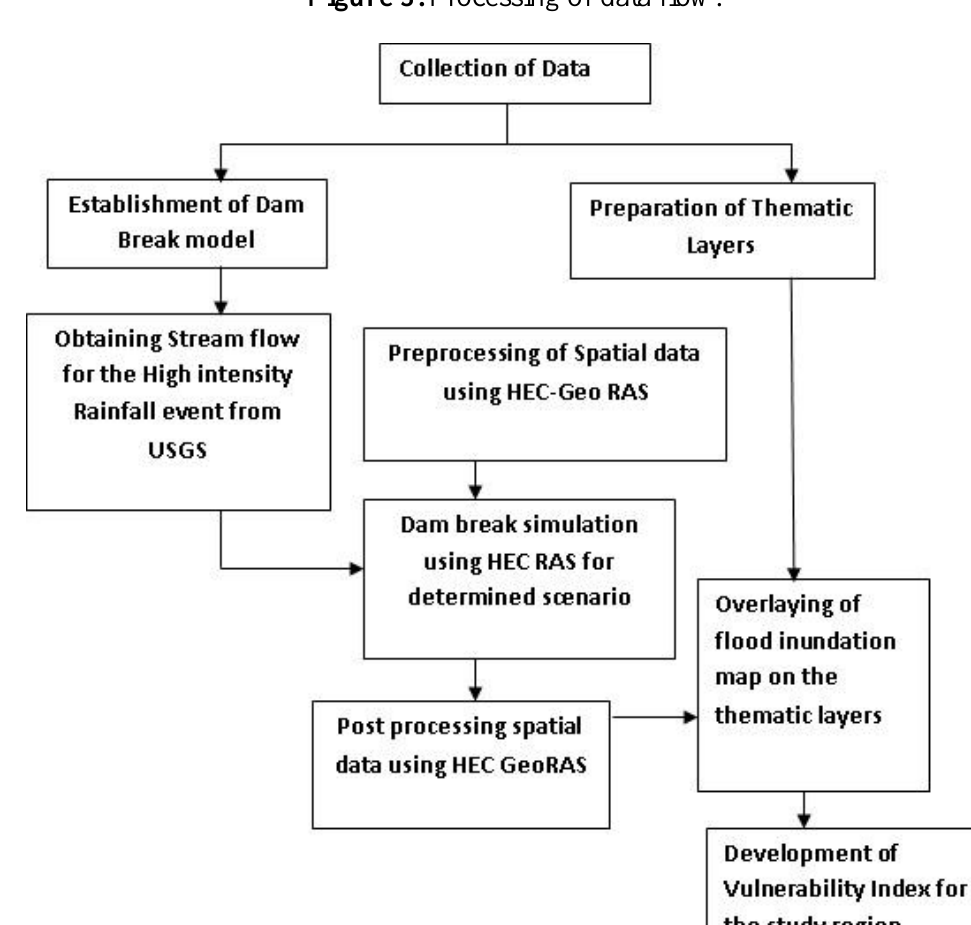
Figure 3. Processing of data